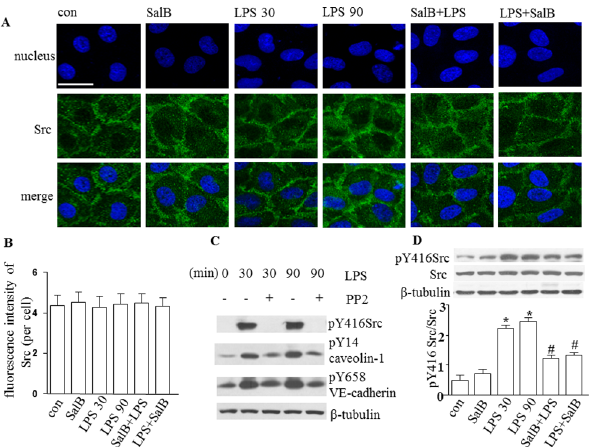
Fig 6. Effect of SalB on Src expression and phosphorylation in HUVECs exposed to LPS. A : Representative images of confocal microscopy showing the distribution of Src (green) in HUVECs in different groups. Hoechst 33342 was applied to stain nuclei (blue). Bar = 25 μ m. B: Quantitative assessment of Src in HUVECs. C: Western blot showing the effect of Src inhibitor PP2 (10 umol/L) on phosphorylation of Src, caveolin-1 and VE-cadherin in HUVECs exposed to LPS. D : Western blot showing the level of Src and phosphorylated Src (Tyr416) and quantification of the level of phosphorylation of Src (Tyr416) in HUVECs in different groups. Data were expressed as mean ± SE of 6 independent experiments. * p < 0.05 vs. control group; # p < 0.05 vs. LPS 30 and LPS 90 groups. One-way analysis of variance (ANOVA) with Turkey post hoc test was